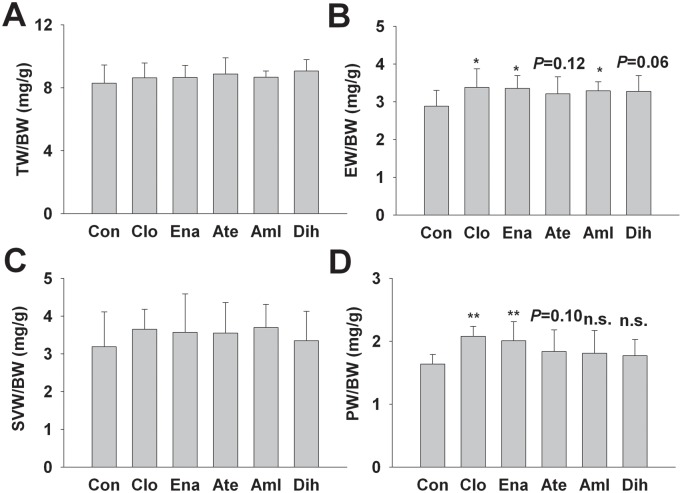
Effects of 3-month treatment of 5 different antihypertensive drugs on the weight of accessory sex organ in SHR.Data are shown as mean ± SD. Data are analyzed by ANOVA followed by dunnett t-testing. *P < 0.05, **P < 0.01 vs. Con; n.s., not significant, n = 10. Abbreviation: TW, testis weight; BW, body weight; EW, epididymides weight; SVW, seminal vesicles weight; PW, prostate weight; Con, control; Clo, clonidine; Ena, enalapril; Ate, atenolol; Aml, amlodipine; Dih, dihydrochlorothiazide.